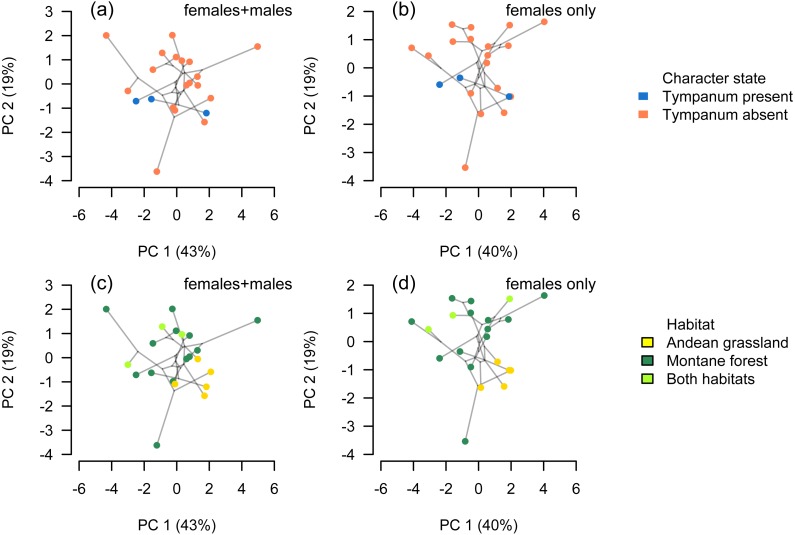
Phylomorphospace.Phylomorphospace projection of Phrynopus species based on body-size corrected data following a phylogenetic size-correction using generalized least-squares (GLS) regression analysis. Body shape in Phrynopus is not associated with tympanum condition (A, B). In contrast, species’ body shape appears to be related to habitat: species that inhabit the Andean grassland occupy a smaller region of morphospace than species that live in montane forest (C, D). The full dataset included data from adult males and females (A, C); the reduced dataset included adult females only (B, D).